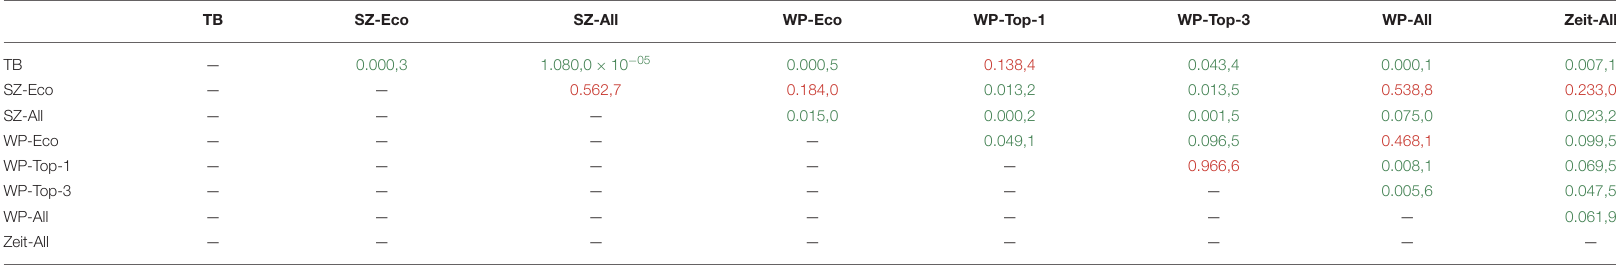
TABLE 4 | P -values of the Kolmogorov-Smirnov goodness-of-fit test applied to the pairwise combinations of the distributions in Figure 4 (compounding-specificity). TB SZ-Eco — SZ-All WP-Eco WP-Top-1 WP-Top-3 WP-All Zeit-All